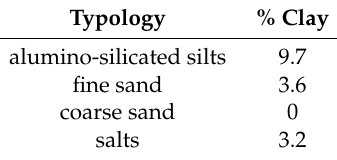
Table 3. Percentage of clay content of four mineralogical populations determined for desert soils